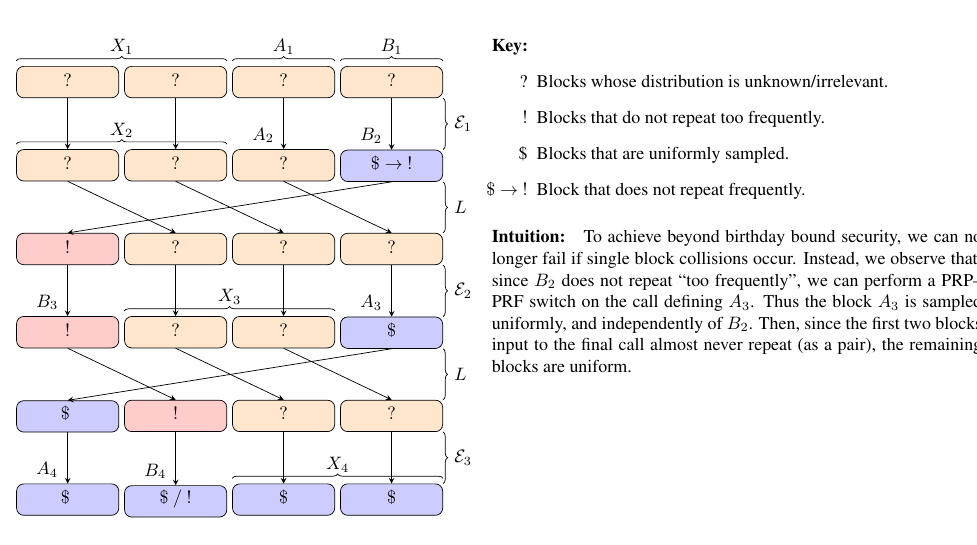
Figure 12: Intuition behind the prp security of Π right